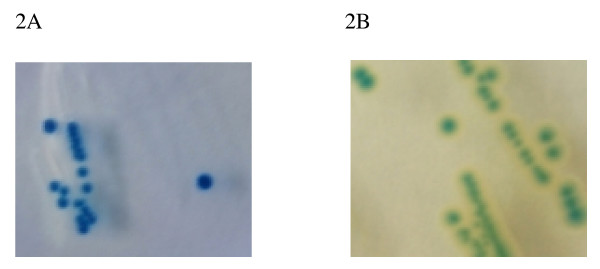
Non-E. sakazakii fruit powder isolate 1160/04 grown as typical colonies on ESIA (A) and DFI (B) media.